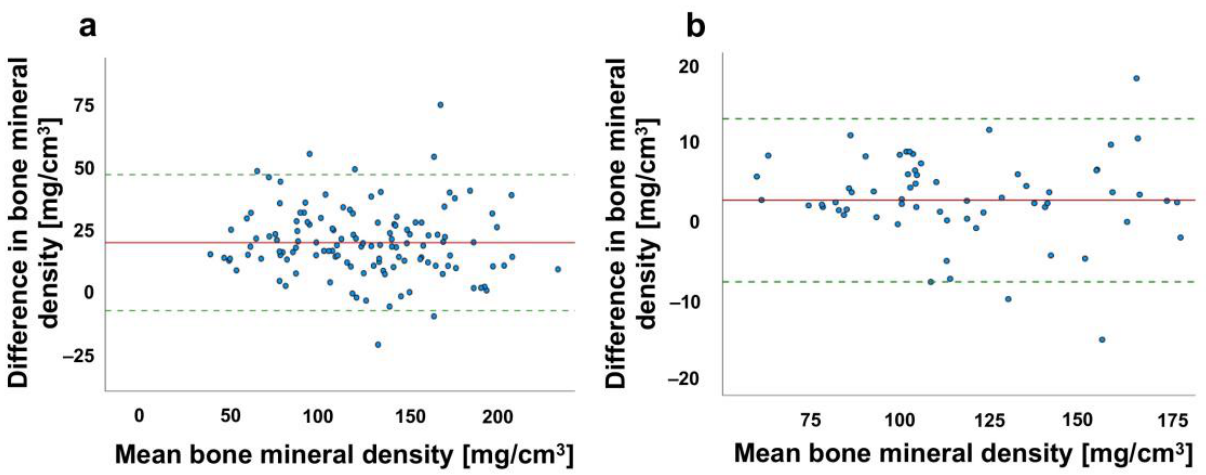
Figure 3. Bland–Altman plot for comparison of bone mineral density (BMD) with and without contrast agent administration. Distribution of BMD of ( a ) spine patient cohort (n = 127) and ( b ) proximal femur patients (n = 70); red line shows the mean value, dashed green lines show the standard deviation (+1.96 and − 1.96) and dots represent the distribution of data sets.